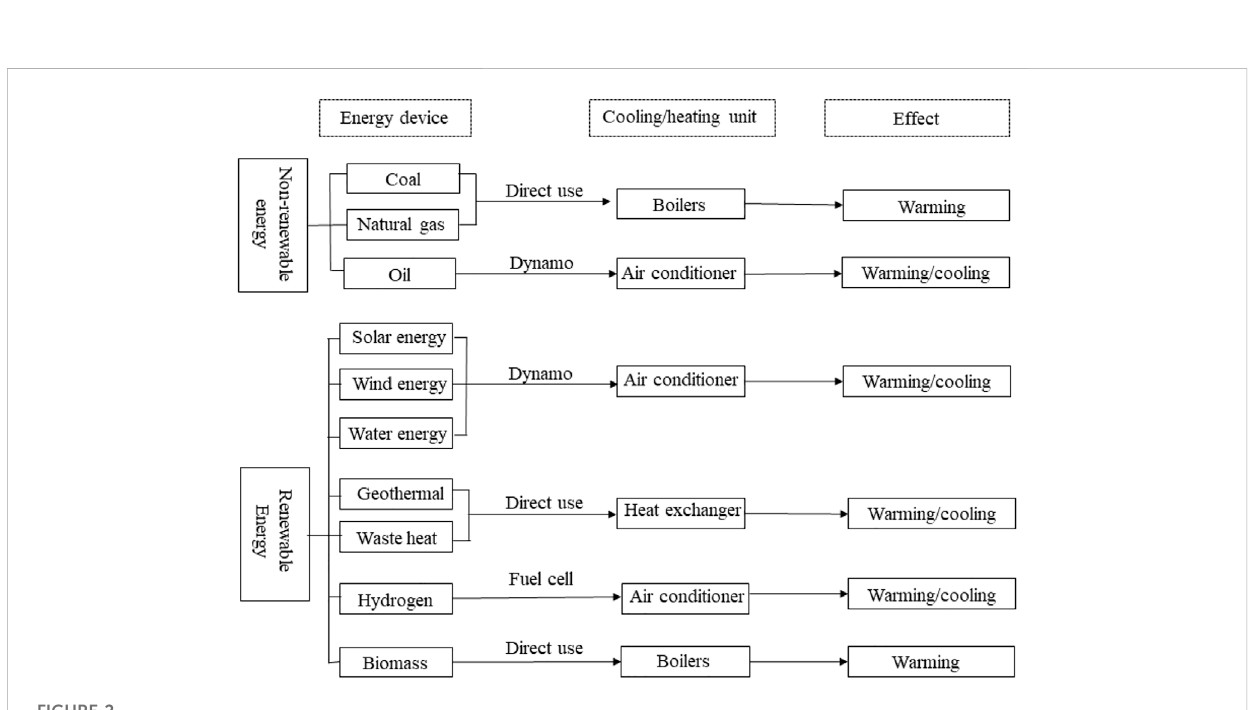
FIGURE 2 Analysis of the energy system of the